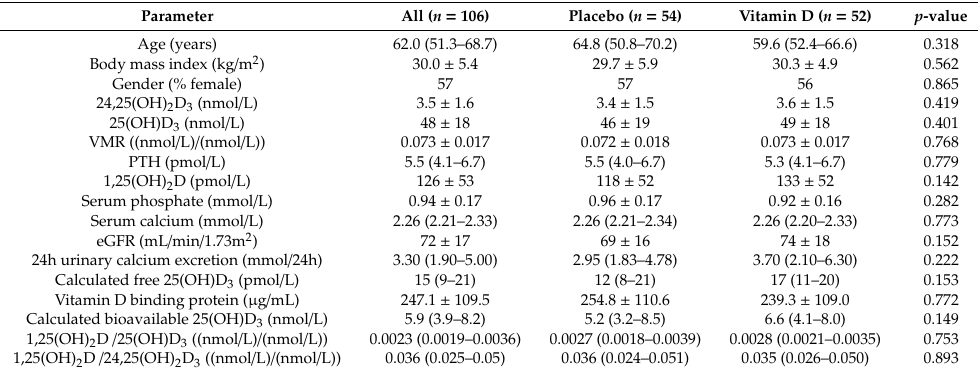
Table 1. Baseline